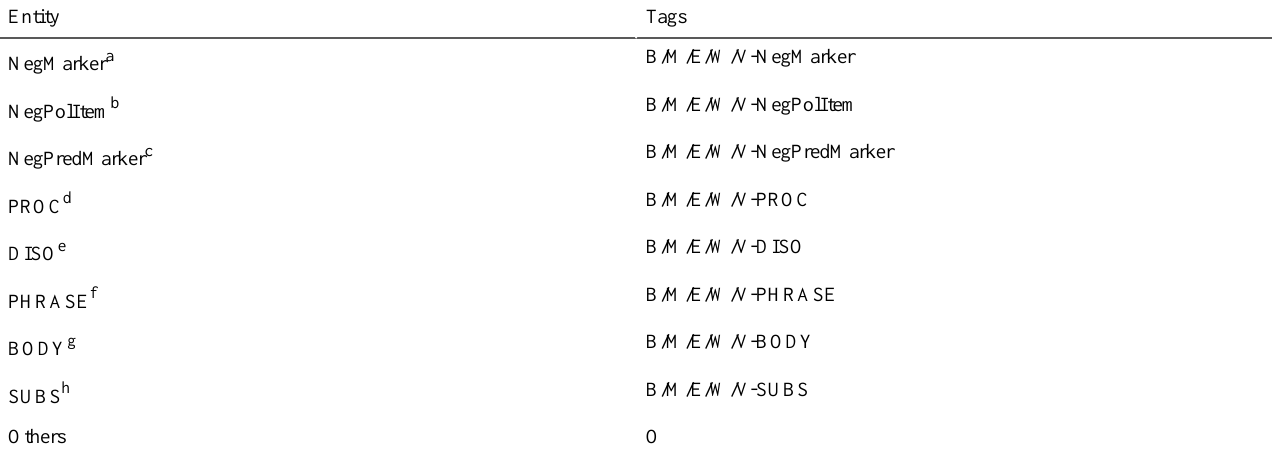
Table 3. Entity tags for BMEWO-V tag encoding in the IULA Spanish Clinical Record